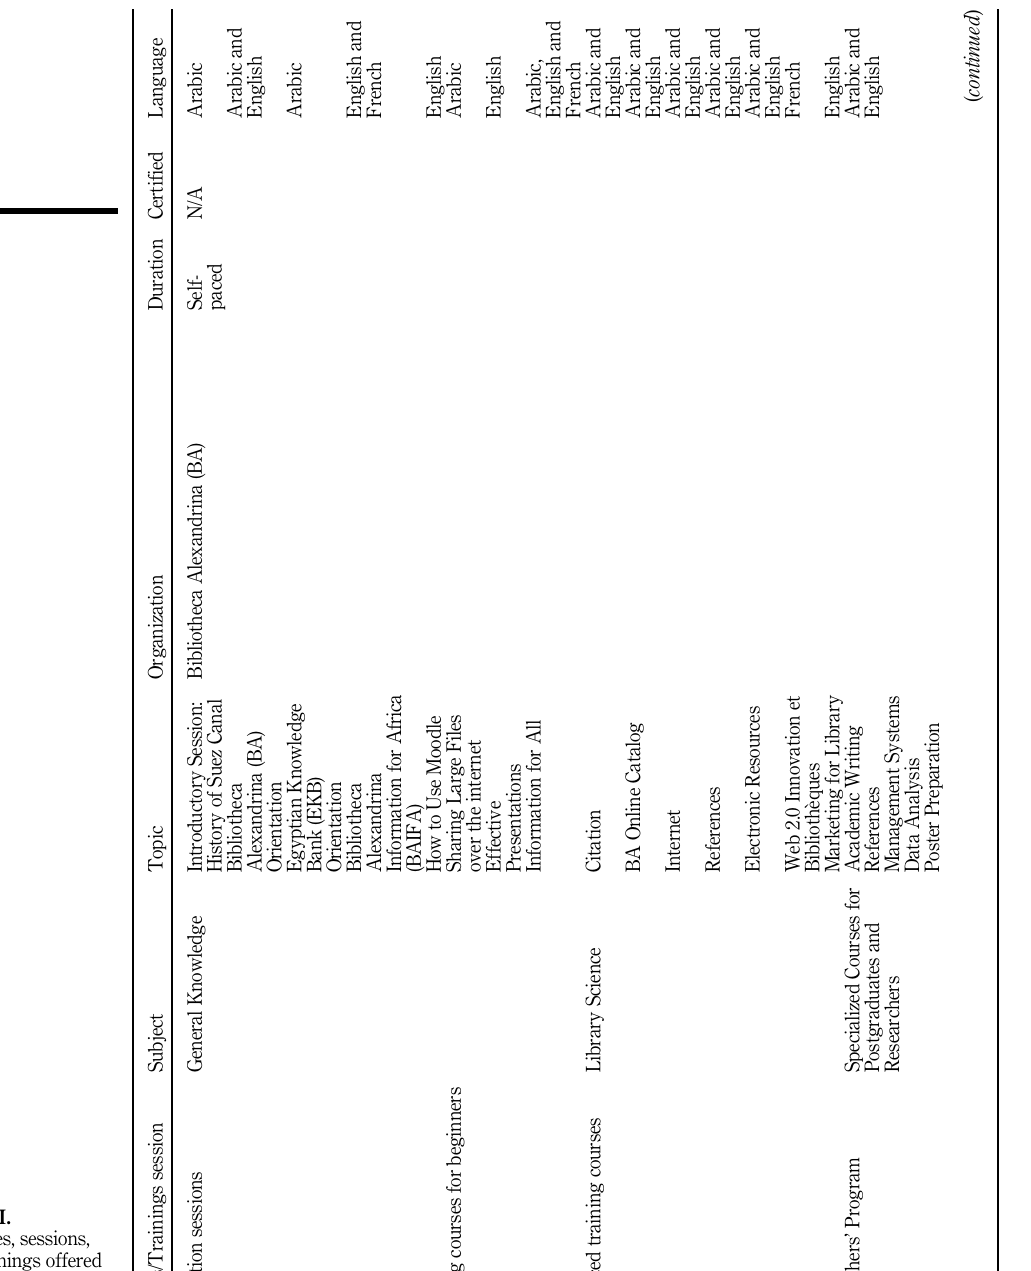
Table II. E-courses, sessions, and trainings offered by the BA E-learning